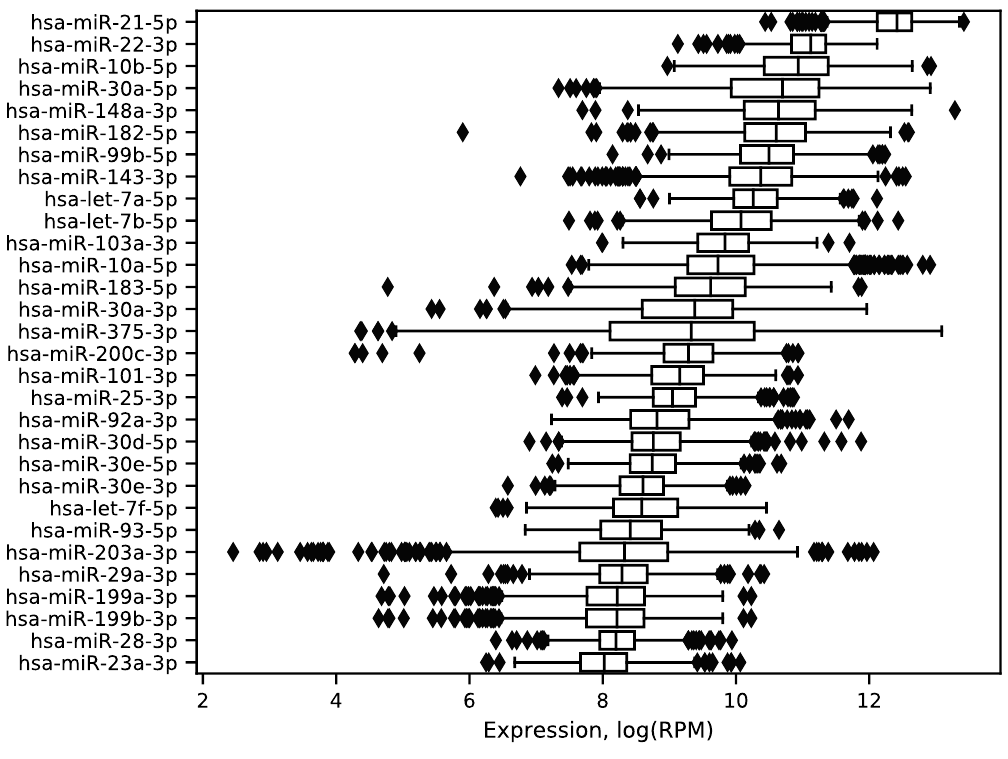
Figure 3. Distribution of the 30 best expressed miRNA expressions in the TCGA miRNA-seq data. The logarithm base 2 was utilized.